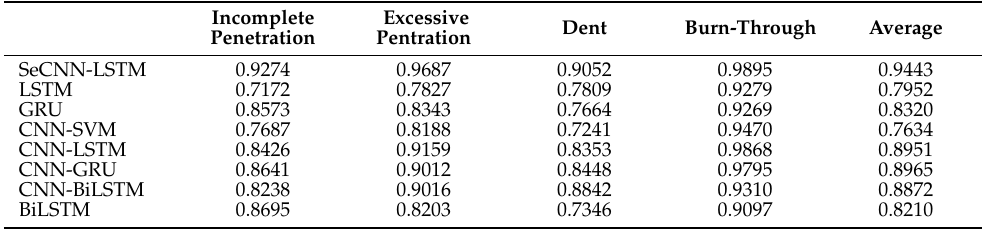
Figure 13. ROC curve comparison. AUC refers to the area values enclosed by ROC curve and coordinates. The closer the AUC value is to 1, the better the model is. When the AUC value is less than 0.5, the model is invalid. It can be seen from Table 4 that the AUC values of all samples of the SECNN-LSTM model are above 0.9, much higher than other models. Table 4. AUC